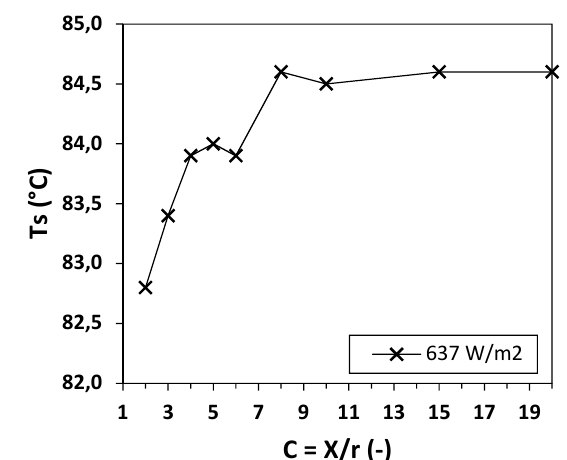
Fig. 7. Surface temperature for q = 637 W/m 2